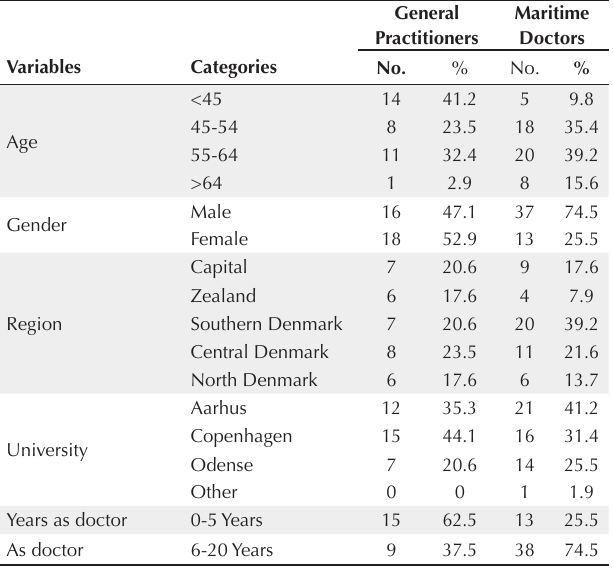
Table 1. Demographic Characteristics of General Practitioners’ (n = 34) and Maritime Doctors (n = 51)